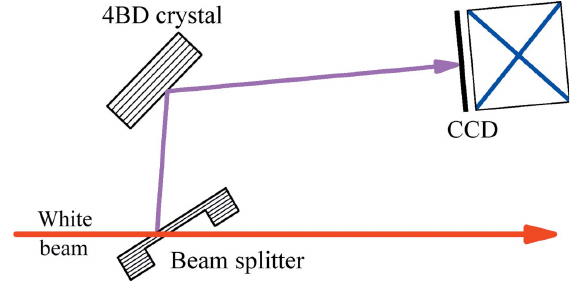
Figure 6 Replacement of the DCM with a thin-crystal window for a 4BD-based BPM with possibly low heat load and minimum thermal lattice distortion on the thin crystal. The thin crystal must be of symmetric Bragg